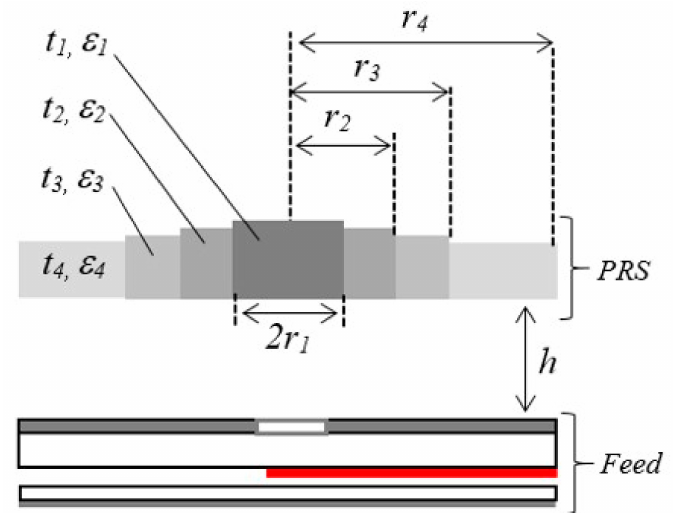
Figure 3. Schematic of RCA constructed by placing the wideband dielectric partially reflecting superstructure (PRS) at a height h above the proposed planar strip-line fed U-slot. Table 2. Design parameters of the wideband dielectric partially reflecting superstructure (PRS) (in mm).